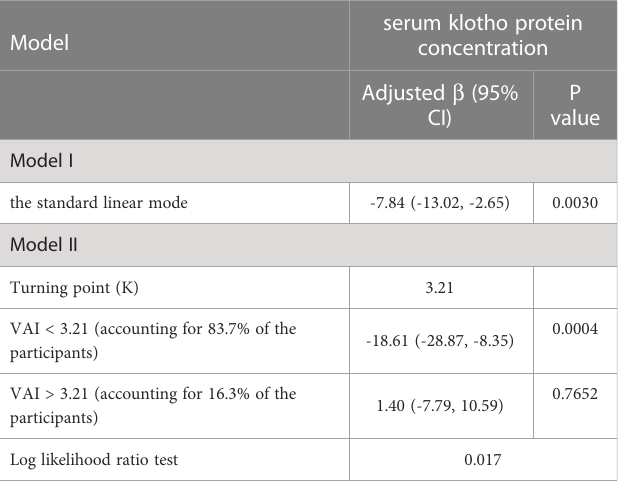
TABLE 3 Threshold effect analysis for the relationship between visceral adiposity index (VAI) and serum anti-aging protein klotho in NHANES 2007 – 2016 a .